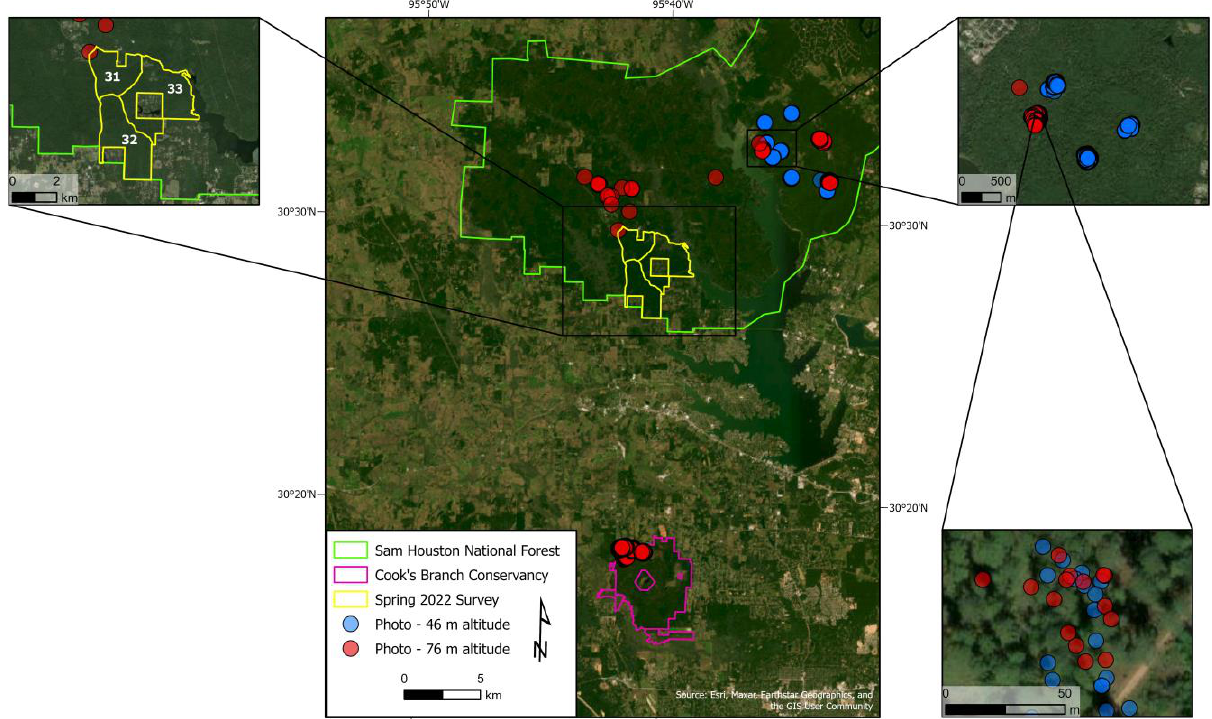
Figure 1. Aerial capture locations for 444 and 532 training sample photos taken at two average altitudes (46 m and 76 m), and the survey area later used for model testing. Photos were collected at both the CBC and the SHNF, with no training samples collected within the survey area in Compartments 31 – 33 on the SHNF. Coordinate System: NAD 1983 UTM Zone 15N. Our basemap was reprinted/adapted with permission from Ref. [38]. Maps throughout this article were created using ArcGIS® software by Esri. ArcGIS® and ArcMap™ are the intellectual property of Esri and are used herein under license. Copyright © Esri. All rights reserved. For more information about Esri ® software, please visit